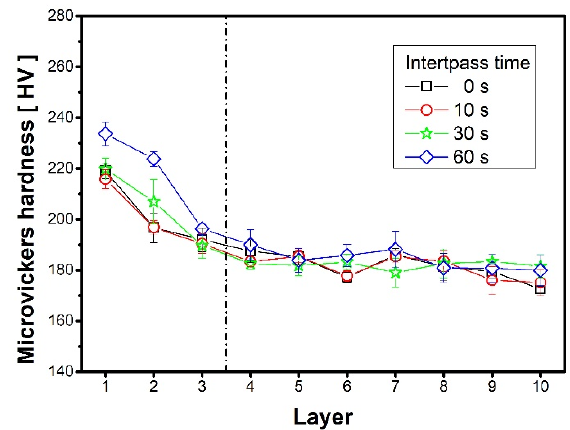
Figure 2. The micro Vickers hardness of deposits in each layer with varying interpass time.